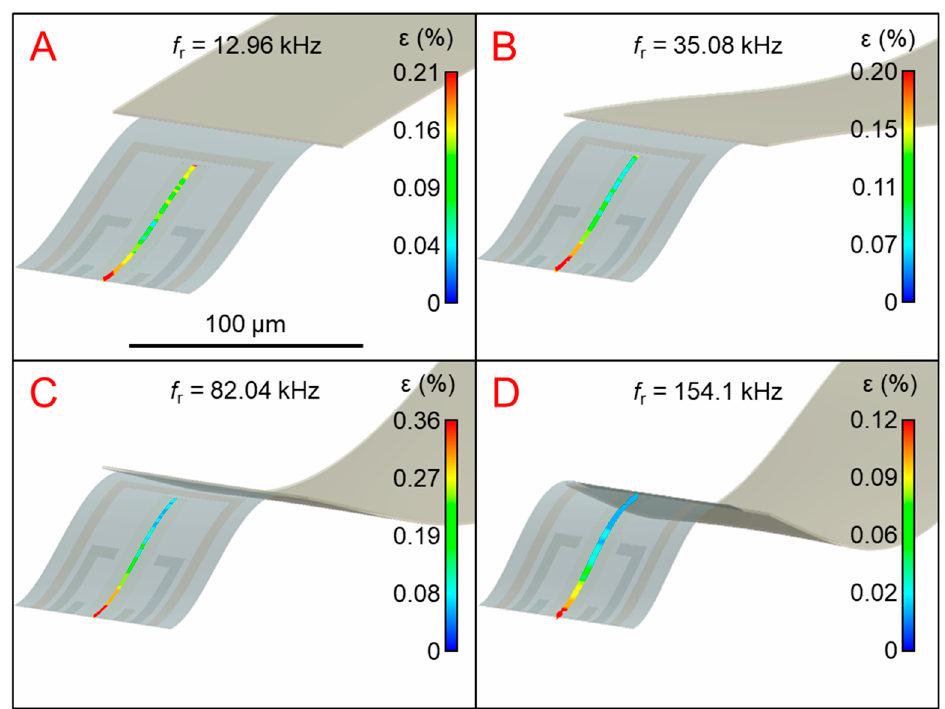
Figure 3. The strain distribution in 2D material placed on the single clamped stretching part. The stretching part is linked mechanically to the single clamped piezoelectric resonator: ( A ) 1st mode at frequency of 12.96 kHz; ( B ) 2nd mode at frequency of 35.08 kHz; ( C ) 4th mode at frequency of 82.04 kHz; ( D ) 5th mode at frequency of 154.1 kHz. The black scale bar is the same for all